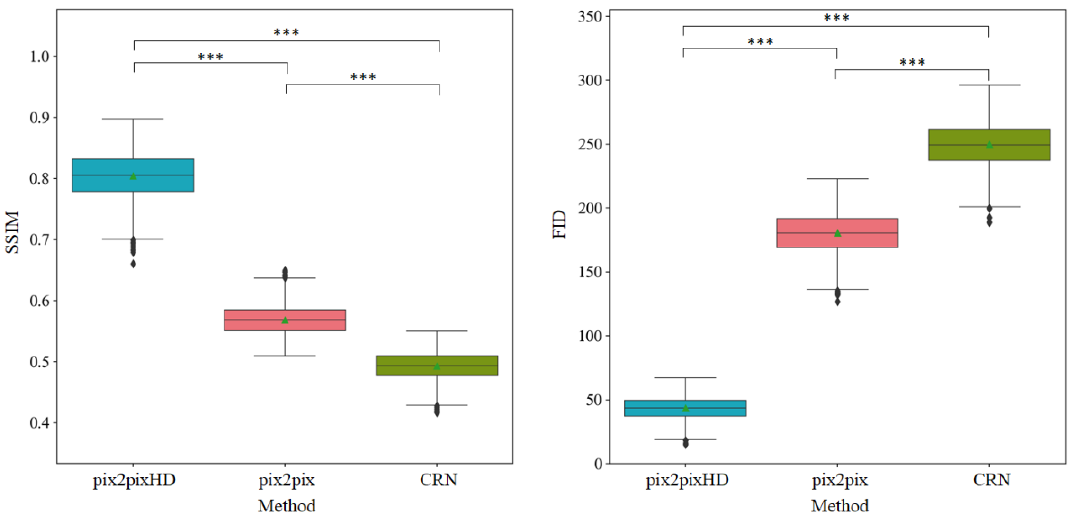
Figure 6. Objective assessment metrics comparison of three methods. Horizontal lines show the significant results of Kruskal–Wallis tests. *** statistical significance with p < 0.001.